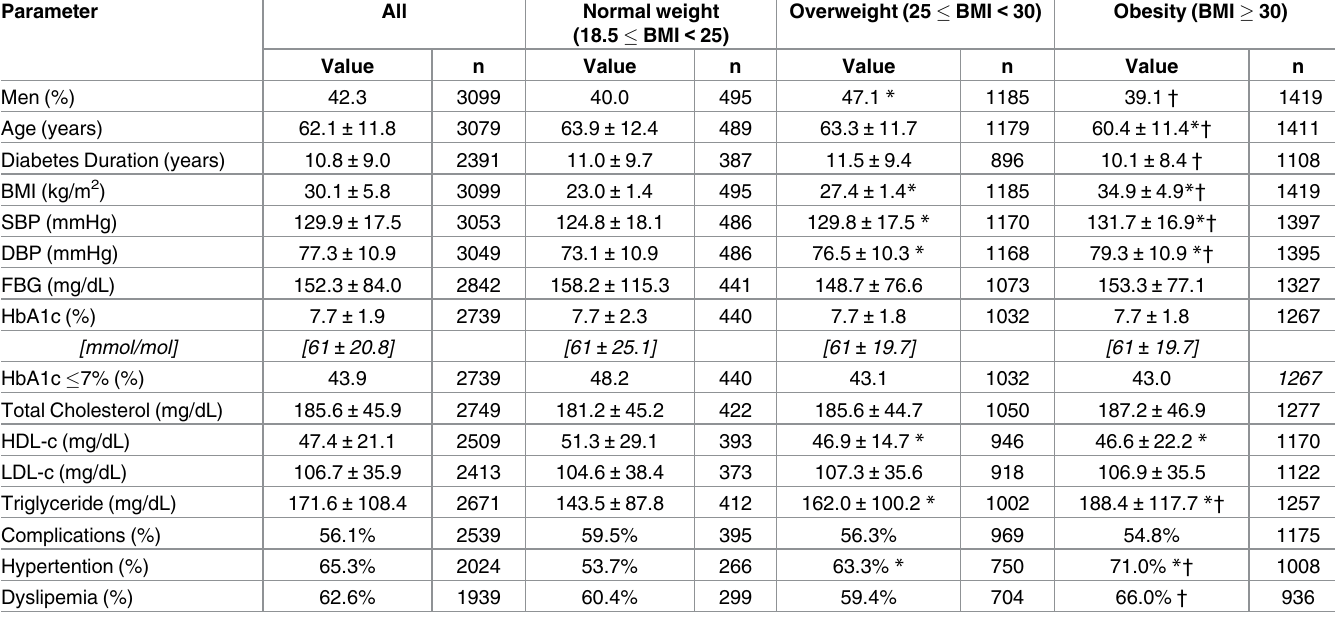
Table 1. Characteristics of the study